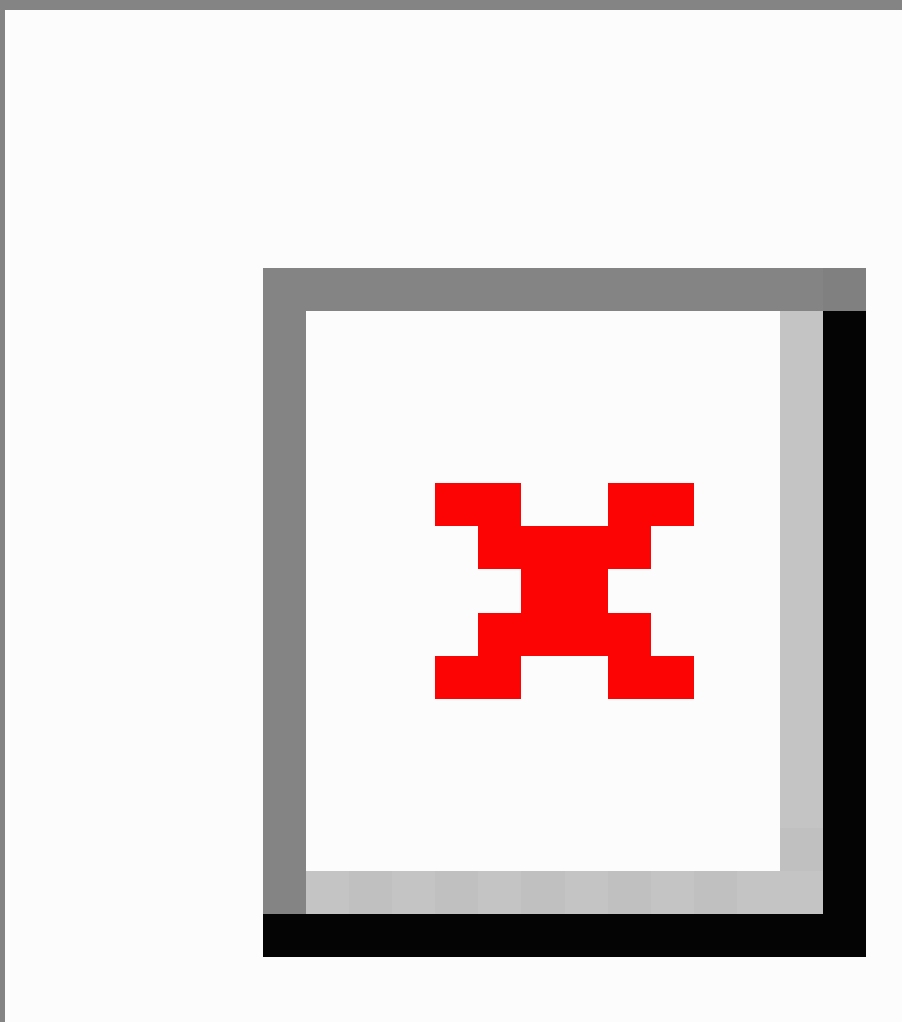
Figure 6. Screenshot of combination mode feedback